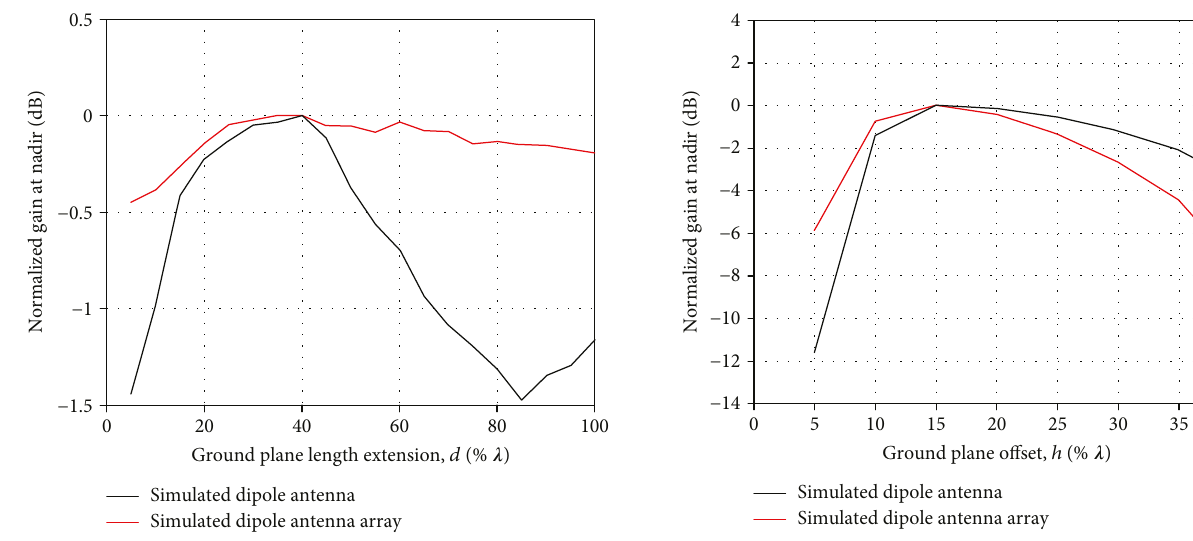
Figure 20: Comparing the ground plane length extension versus normalized gain at nadir for the single dipole element and array.